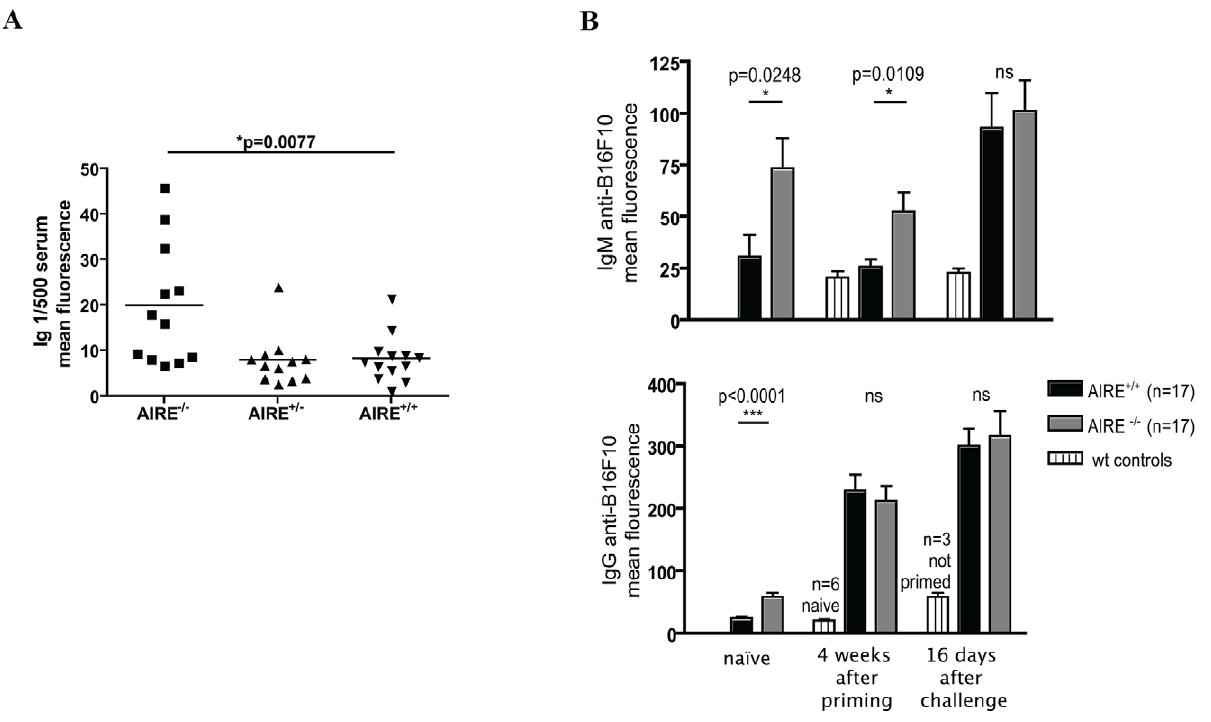
Figure 3. Anti-B16F10 antibodies serum levels are elevated. Mice of the indicated genotype were primed with 5 6 10 6 irradiated B16F10 and challenged with 2.5 6 10 5 live B16F10. A At time of sacrifice (when tumours reached 10 mm 2 or in the case of tumour-free mice after 50 days), serum was obtained. 1/500 diluted serum was used to stain B16F10. Secondary antibody was an anti-mouse pan Ig APC. B Serum was obtained before priming, 4 weeks after priming, or 16 days after live tumour challenge and used to stain B16F10. Naı¨ve littermate controls or unprimed but challenged controls were included were indicated. Secondary antibodies used were anti-mouse IgM FITC (upper panel) or anti-mouse IgG FITC (lower panel). * p value by Mann-Whitney test comparing mean fluorescence of serum staining B16F10. These findings were reproduced three times with similar results with n . 10 in each group.